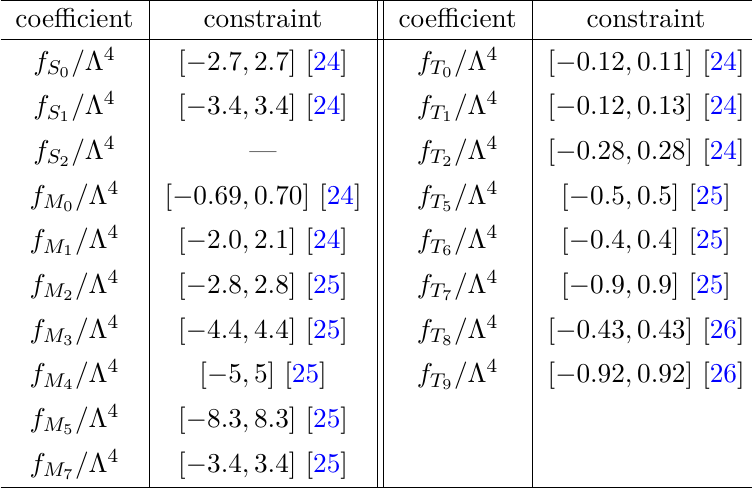
Table 1 . The LHC constraints on the coefficients (in unit of TeV − 4 ) of dimension-8 aQGC operators obtained at 95%